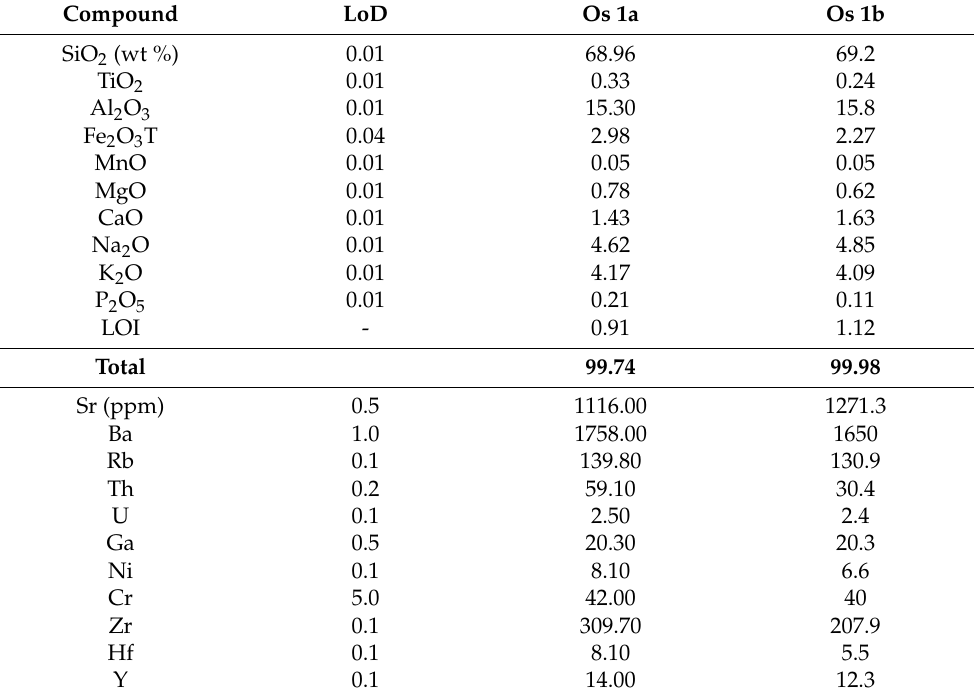
Table 4. Chemical composition and selected petrological indices of the whole-rock samples of exotic crystalline